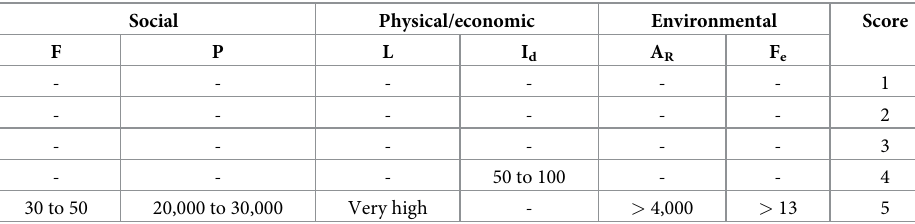
Table 5. Class and scores for FV attributes for Chhukha district.